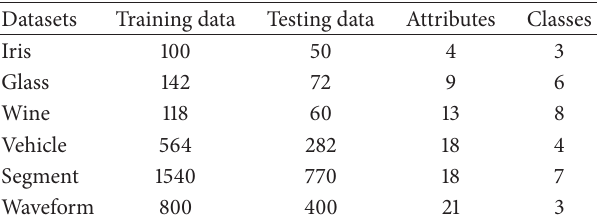
Table 5: Specifications of multiclass classification cases.